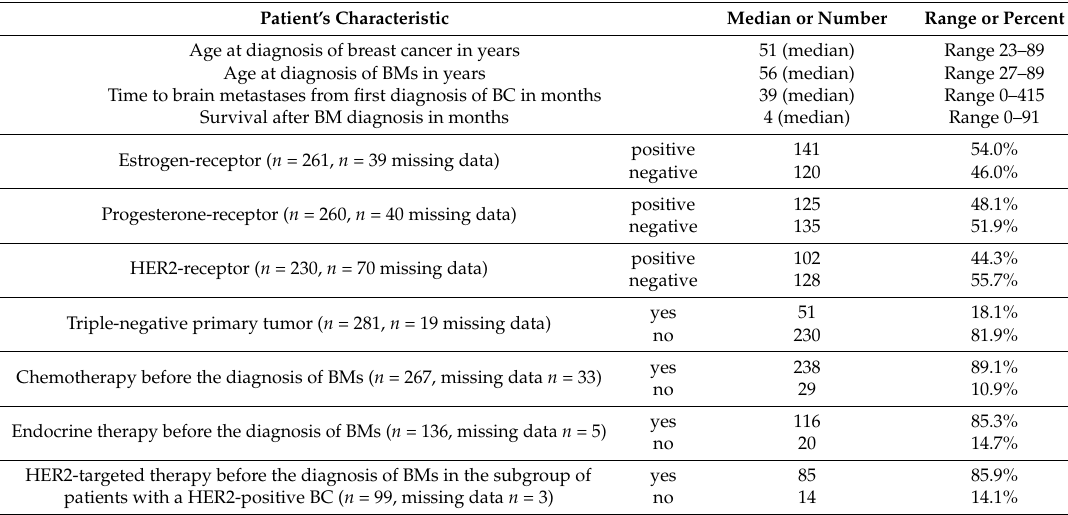
Table 1. Patients’ characteristics.